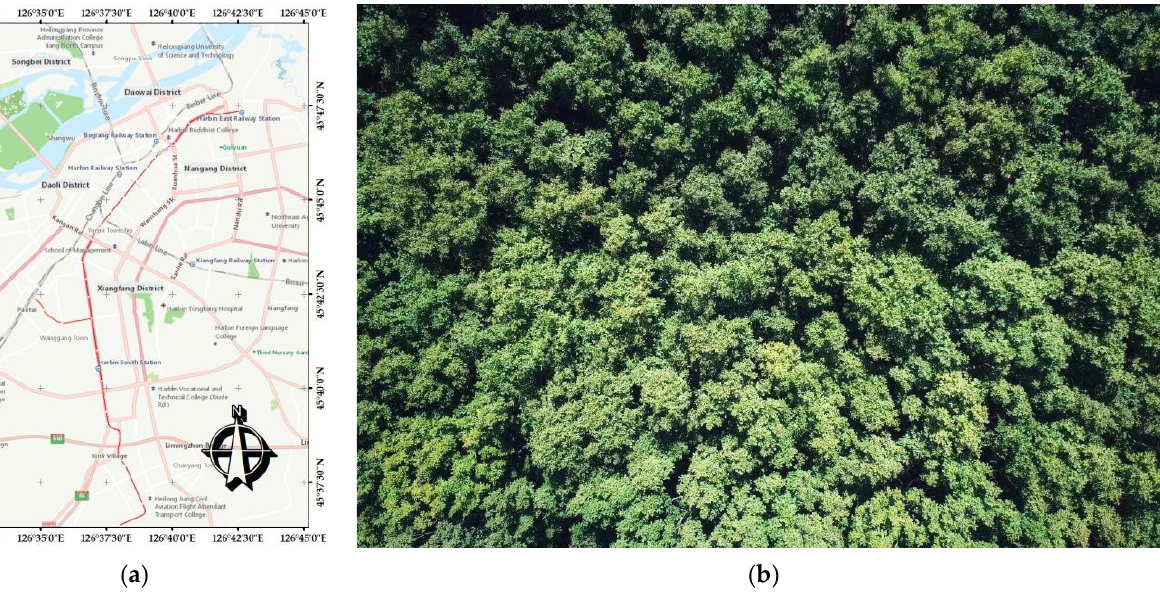
Repeat Figure 2. The side view of collected point cloud file with no color. 2.3. Methodology The methodological workflow (Figure 3) consisted of the following steps: (1) prepro- cessing to gain a simplified forest point cloud, including denoising and ground filtering; (2) individual tree segmentation to obtain a single tree point cloud; (3) creating our own data set, resampling, normalizing, and centralizing the single tree point cloud, adding la- bels and then dividing the training set and test set; (4) classifier selection, including train- ing and parameter adjustment; and (5) comparative experiments and evaluation, and the